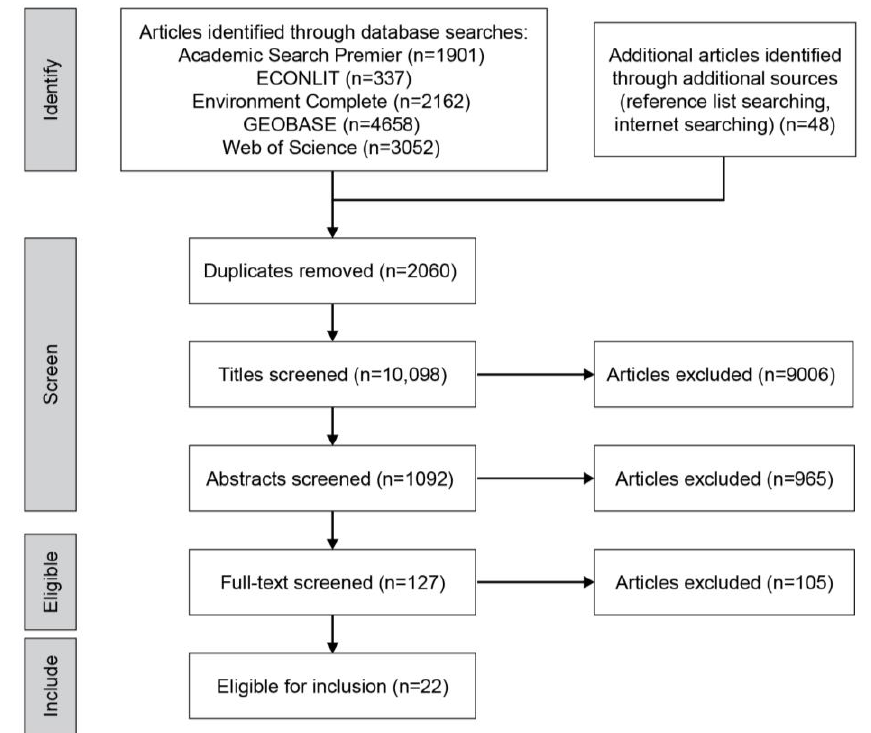
Figure 1. Qualitative Systematic Review Process. The qualitative systematic review process included a search of five databases using terms such as urban development, externalities, and tax (complete list in Appendix A), which initially produced 12,110 articles eligible for analysis. Through additional searching of reference lists and internet searches, 48 additional articles were included. From these, 2060 duplicate articles were identified and removed. The remaining 10,098 articles were screened for relevance, first by title, and then by abstract. This produced 127 articles eligible for full-text screening. The final, full-text screening identified 22 articles for inclusion in the analysis. These 22 articles met a set of content criteria, including a range of broadly applicable negative externalities covered by the sample as a